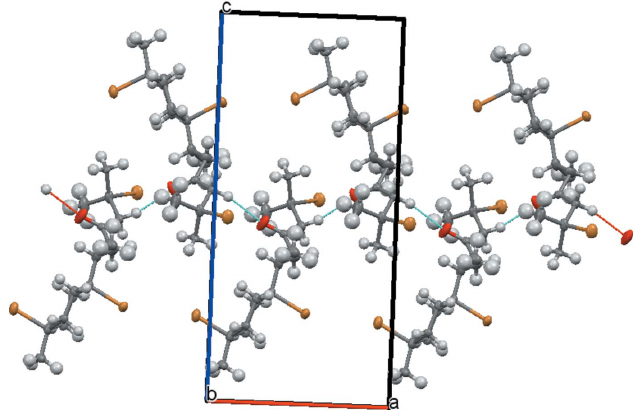
Figure 2 A partial view down [010] of the crystal packing of the title compound, showing the C—H (cid:2)(cid:2)(cid:2) O hydrogen bonds as blue lines (see Table 1).